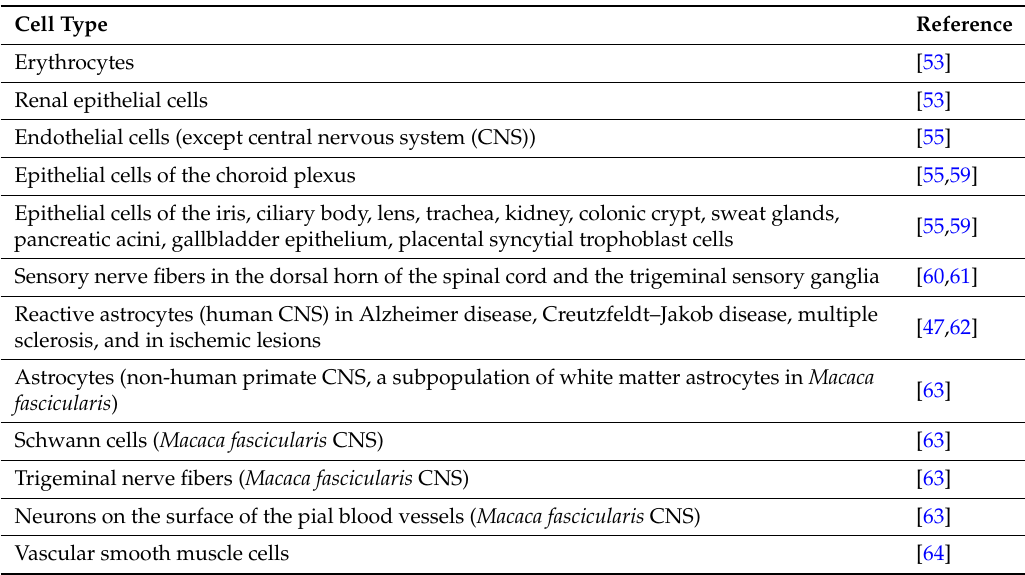
Table 2. The expression of AQP1 in different